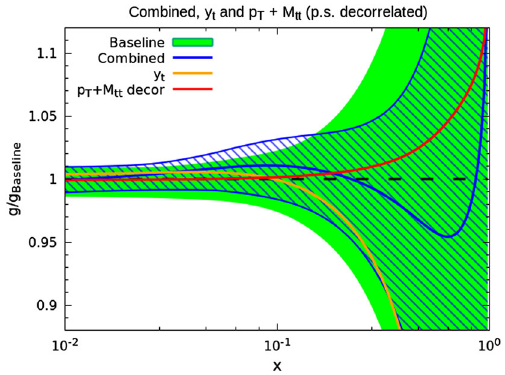
Fig. 4 As in Fig. 1, for fits to different distributions taken in the liter- ature: y t and p T + M tt (with decorrelation of the parton shower sys- tematic error), as well as the combined fit